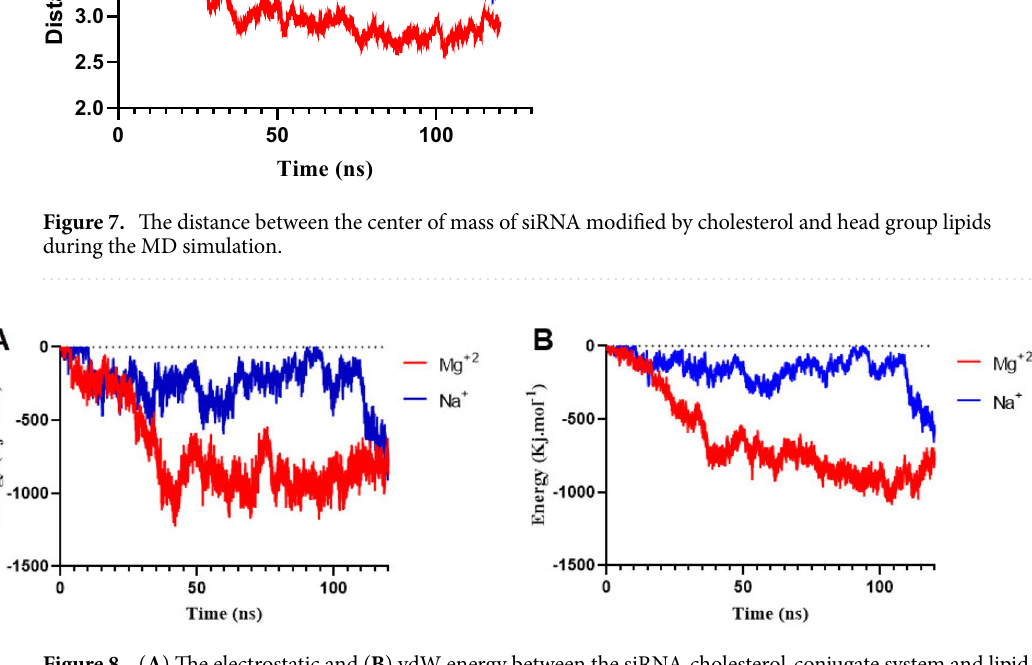
Figure 8. ( A ) The electrostatic and ( B ) vdW energy between the siRNA-cholesterol-conjugate system and lipid bilayer in the presence of Mg 2+ ions and in the presence of monovalent ions.